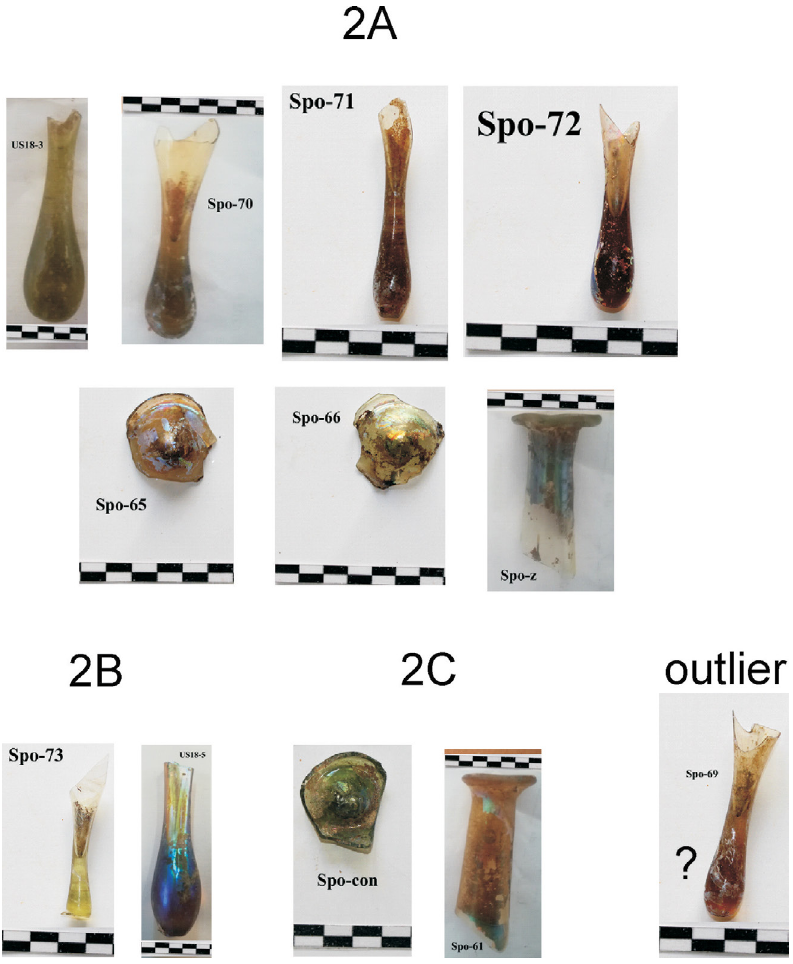
Figure 3: Vitreous finds of the second group dated from 12 th –13 th century